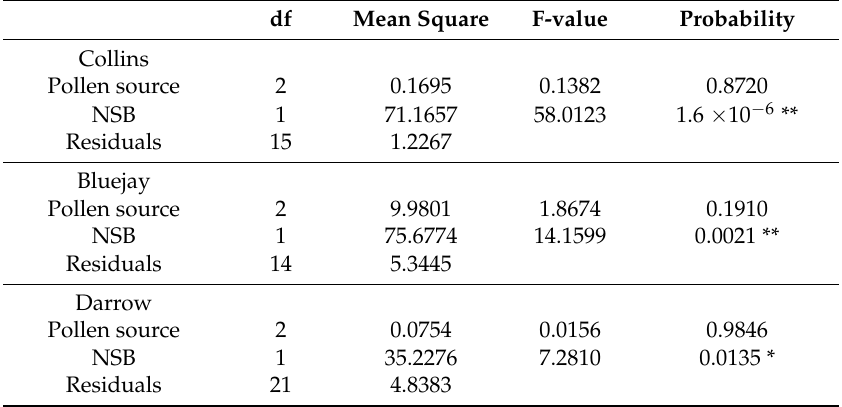
Table 7. Results of ANCOVA with NSB as a covariate determining the differences in adjusted DSII in each pollination by different sources of pollen.